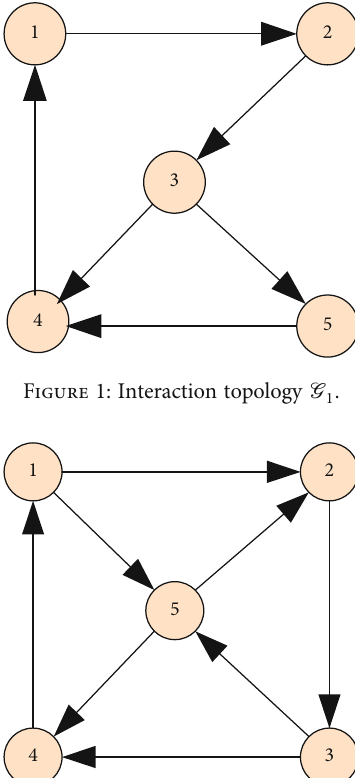
Figure 2: Interaction topology G